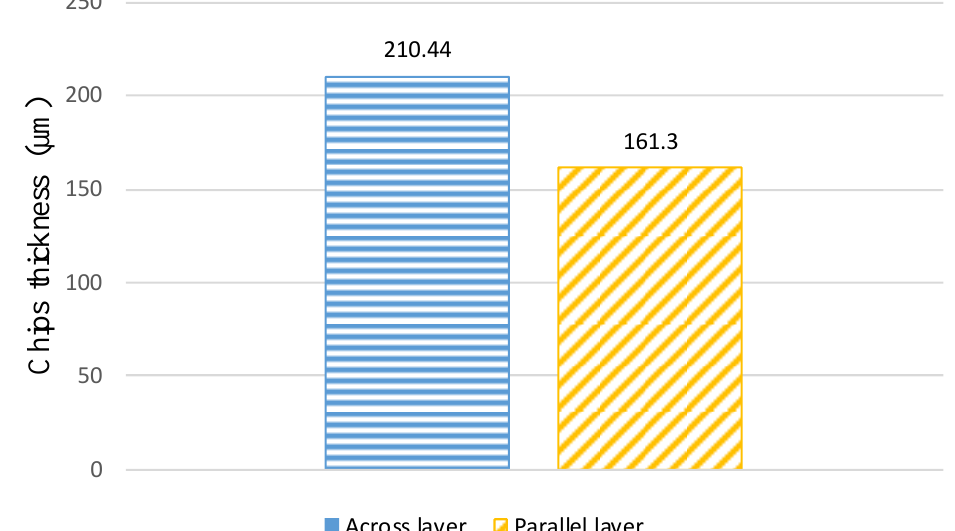
Figure 10. Chips’ thickness measured for AL and PL orientations at f = 0.1 mm/rev, V = 60 m/min, and d = 0.2 mm.